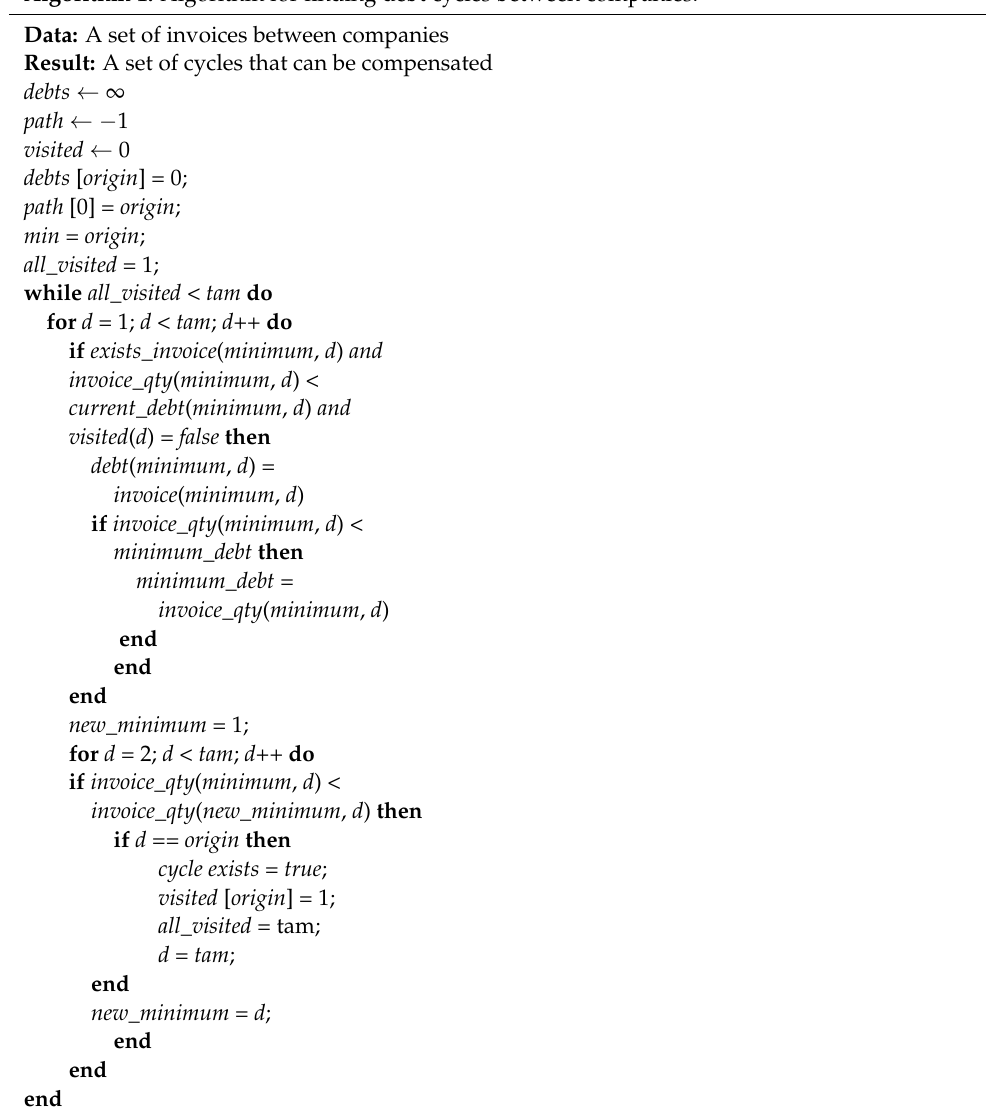
Algorithm 1: Algorithm for finding debt cycles between companies.